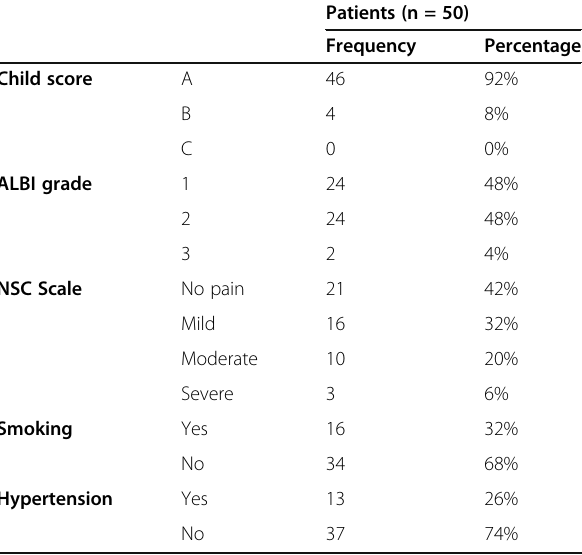
Table 2 Clinical characteristics of the patients